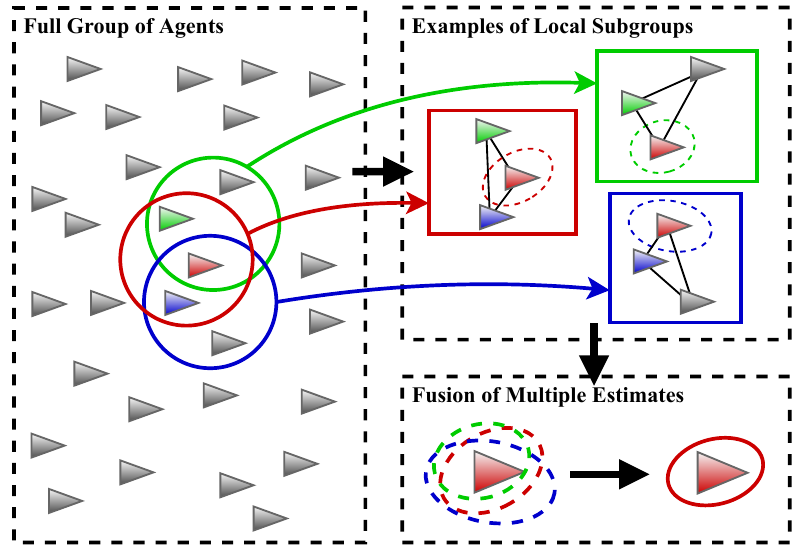
Figure 1. Illustration of the proposed framework for map matching based cooperative localization. ( Left ) A large group of agents is divided into subgroups based on communication constraints where one subgroup is created for each agent. ( Upper right ) The geometry of the subgroups (i.e., the relative positions inside the subgroups) are estimated, using range-only measurements, then the geometry is used to extract measurements of the scalar field to estimate the pose and associated uncertainty of each member in the subgroup. ( Lower right ) An agent, as an example, receives multiple copies of its pose estimate through its membership in several subgroups and fuses them to reduce pose